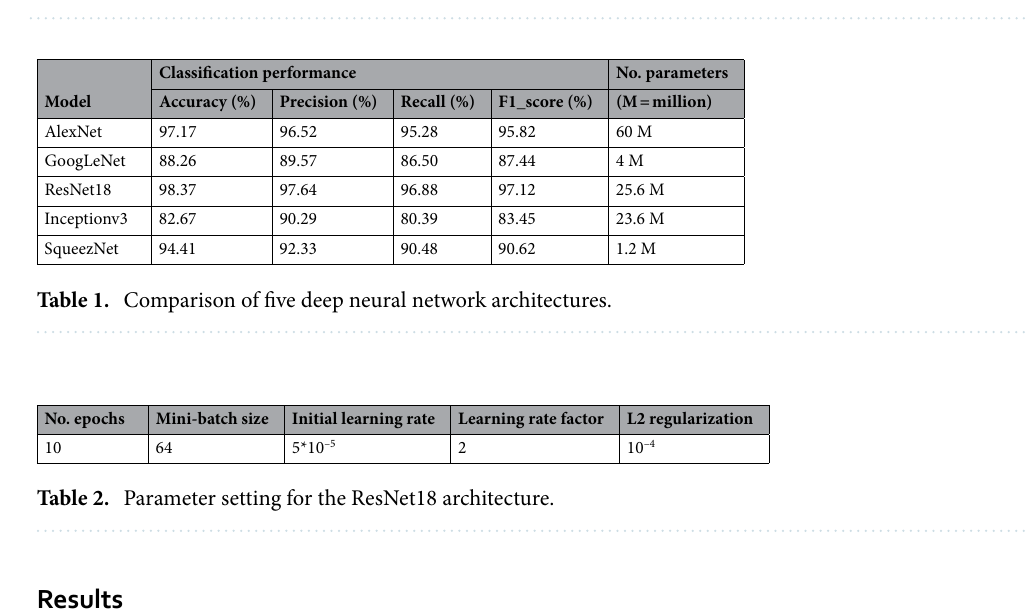
Figure 1. Overview of the combined microfluidic deep learning approach.